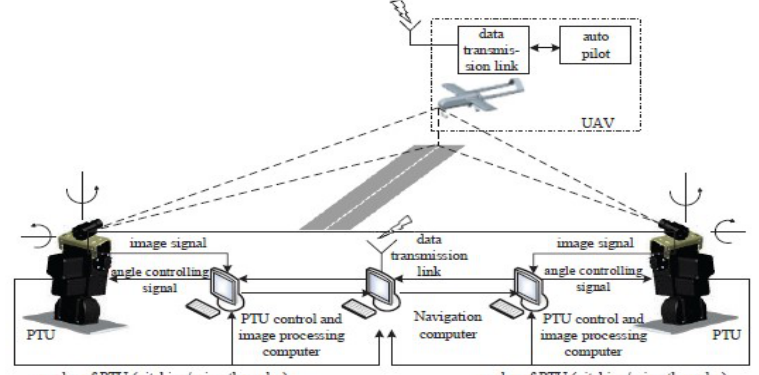
Figure 1. Architecture of the system.